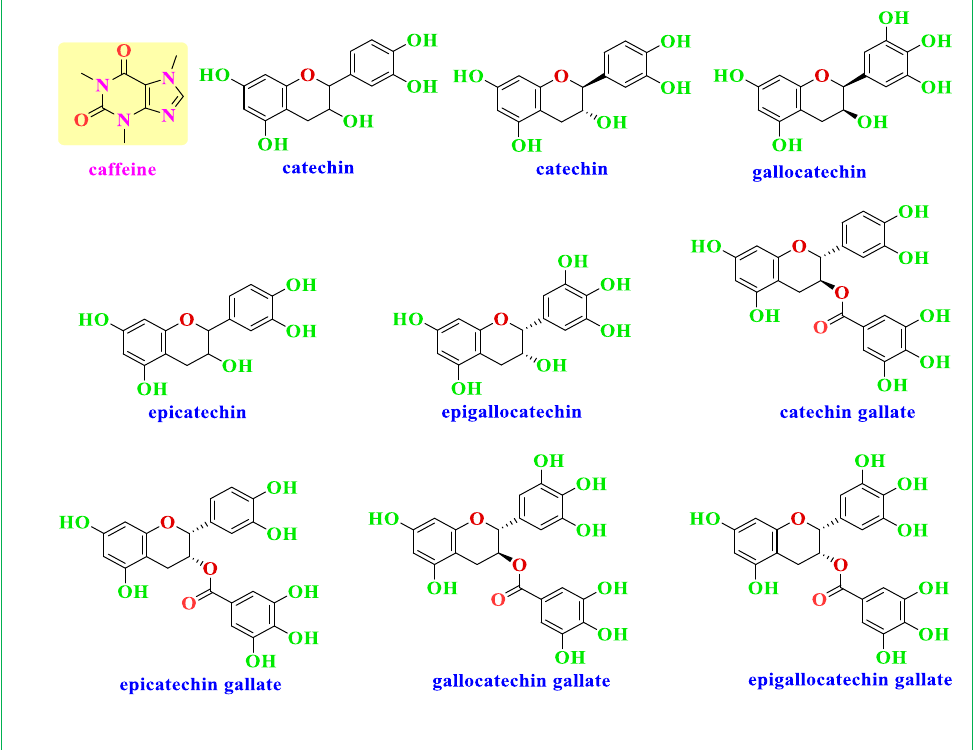
Figure 1. Components of GT extract enriched with caffeine and catechin (molecules that contain OH functional groups).